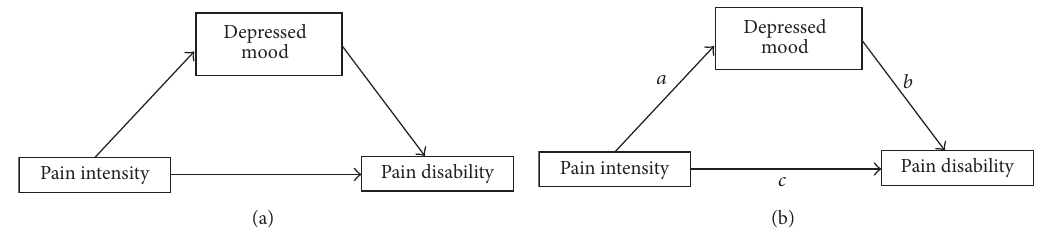
Figure 1: Conceptual (a) and statistical (b) diagrams of the simple mediation model [10].